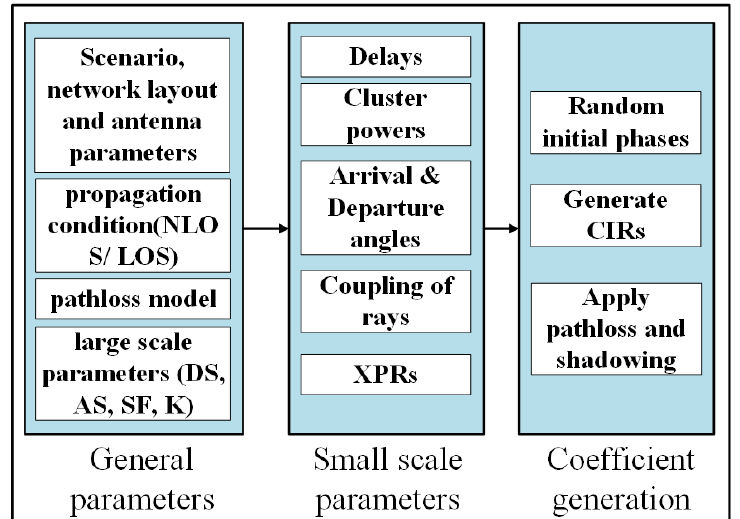
Figure 6. Framework of primary module in IMT-2020 channel